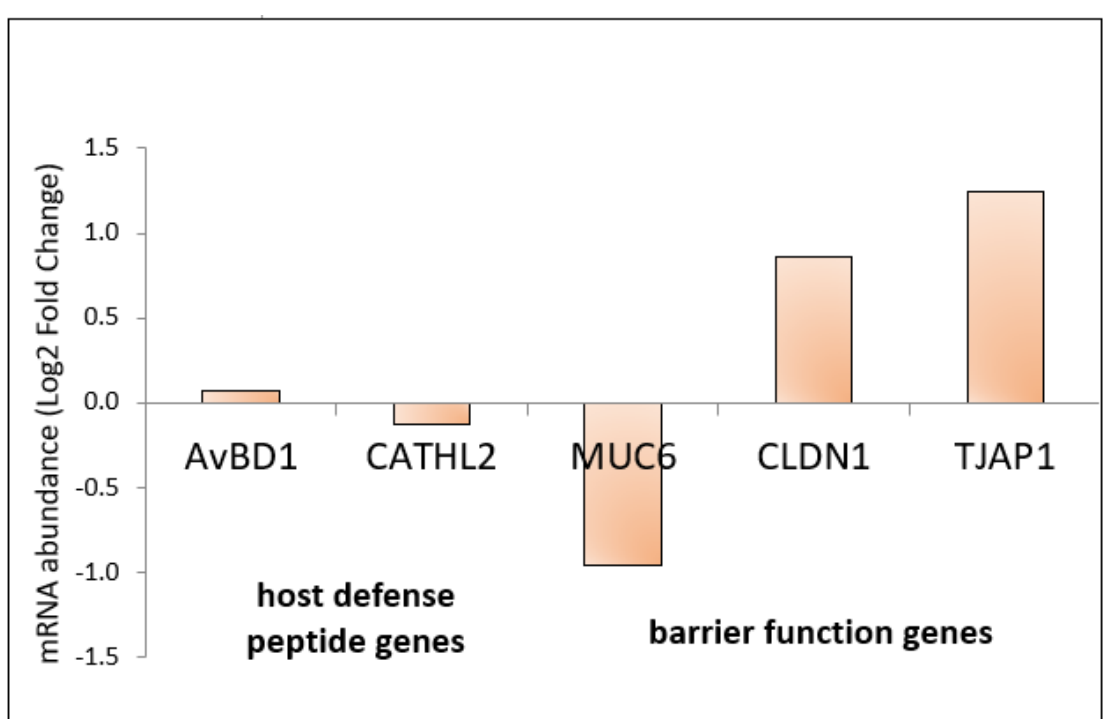
Figure 4. Relative gene expression of host defence peptide genes and barrier function genes in cecal mucosa in chickens supplemented with zeolite in feed and bedding. Statistical analysis consisted of comparing the experimental groups with the cont rol group using Student’s t -test.